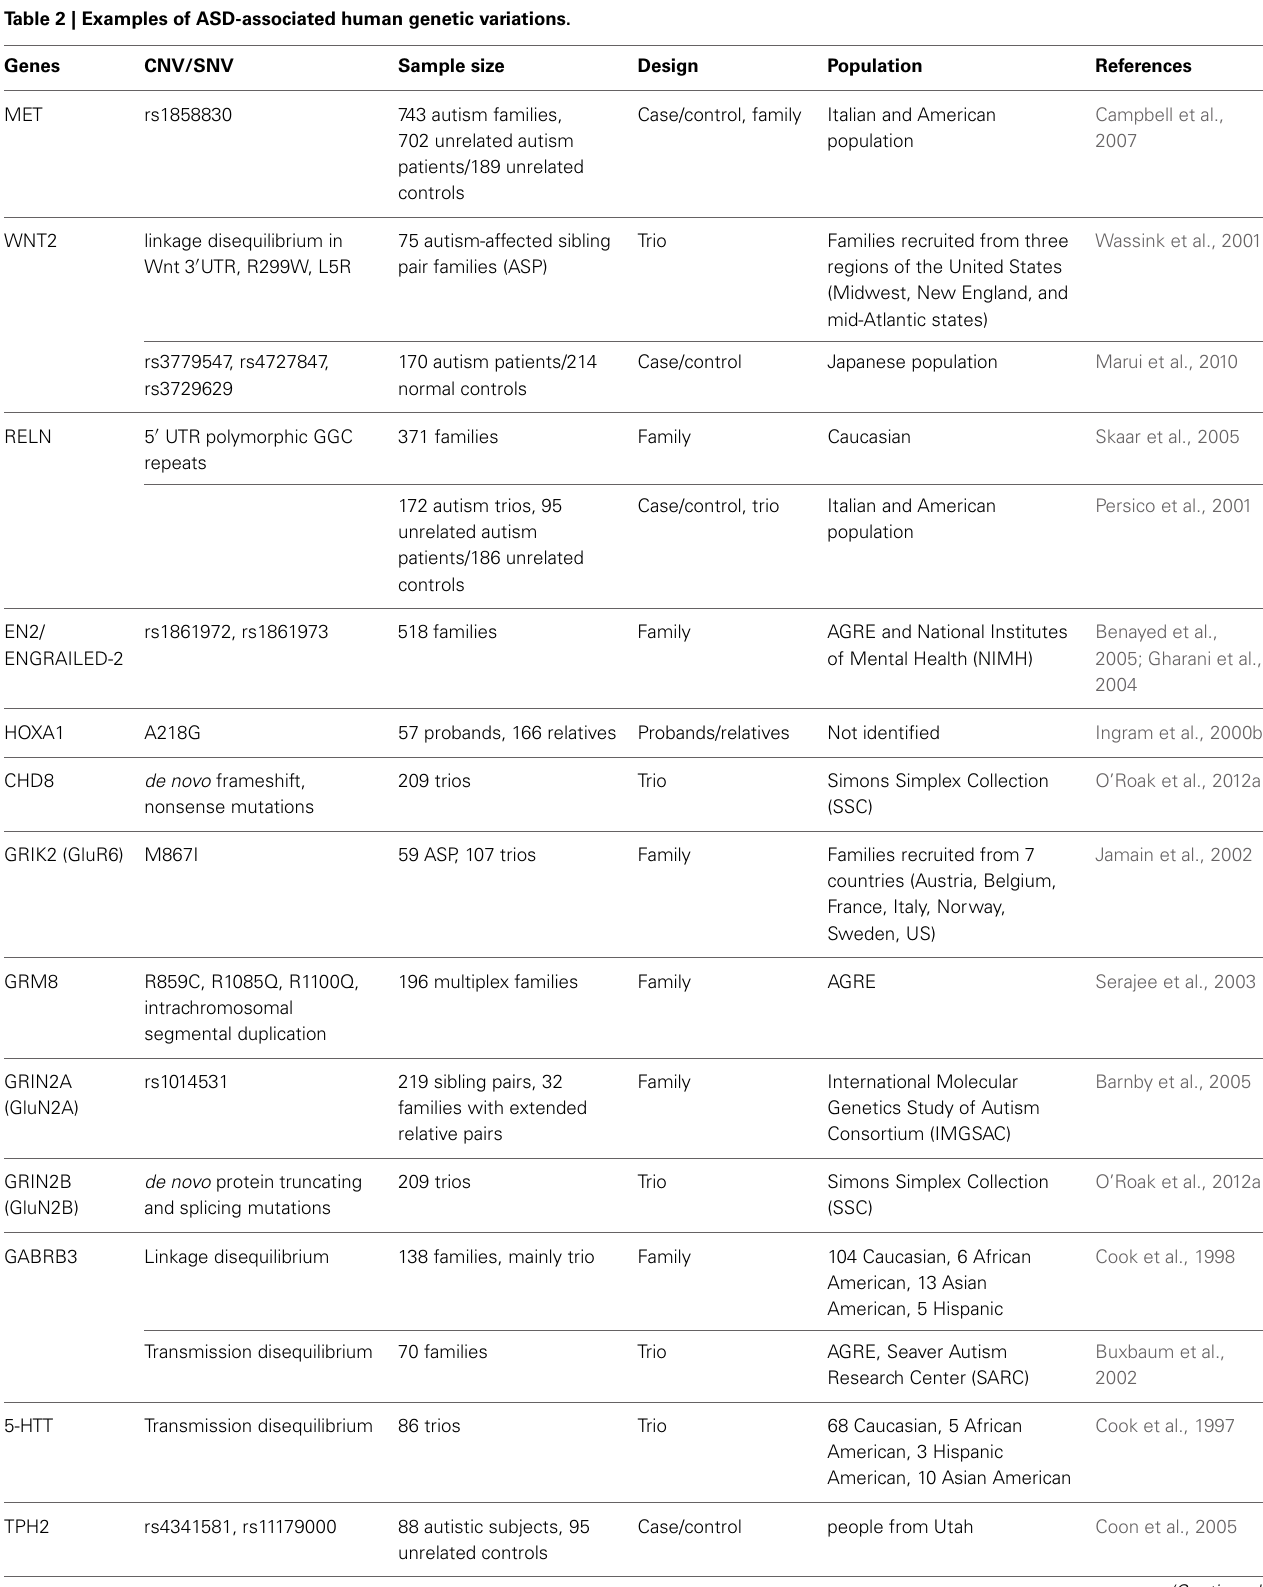
Table 2 | Examples of ASD-associated human genetic